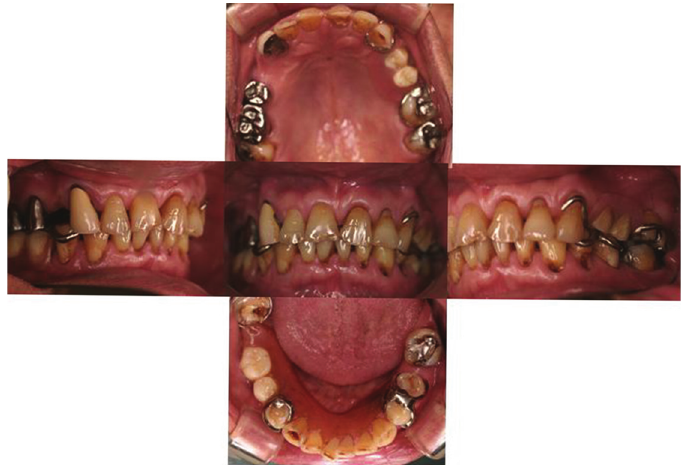
Figure 1: Oral view at the first